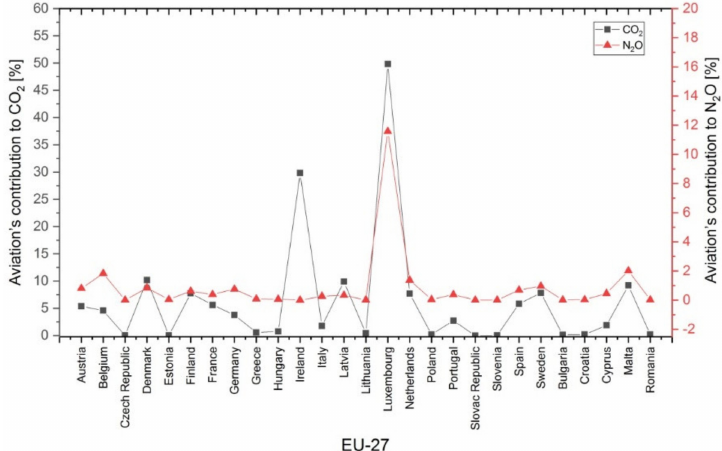
Figure 6. Percentage of aviation’s contribution to carbon dioxide (CO 2 ) and nitrous oxide (N 2 O) emissions in the 27 European Union (EU-27) member states (2018, %)